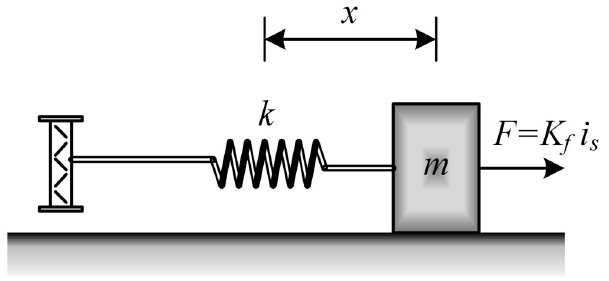
Fig 6. Mechanical subsystem of